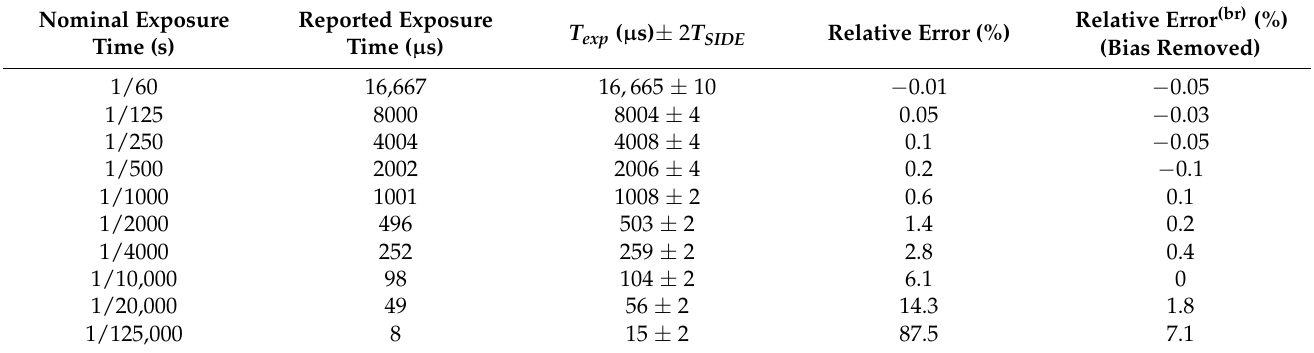
Table 5. Measurement results of C3, using the multi-timer running LED method.